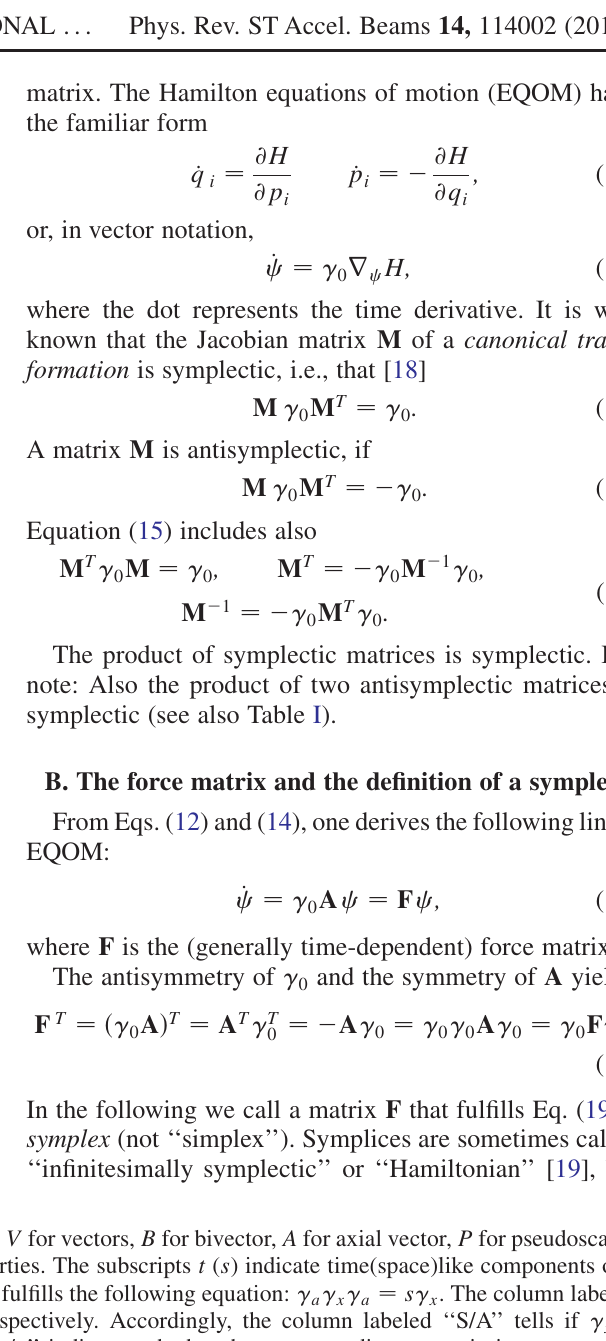
¼ s(cid:1) (cid:1) (cid:1) . The column labeled a x a x is x plays the x